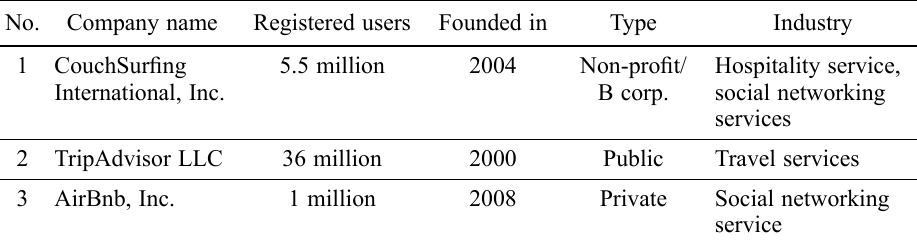
Table 1. Companies providing value co-creation in online travel services